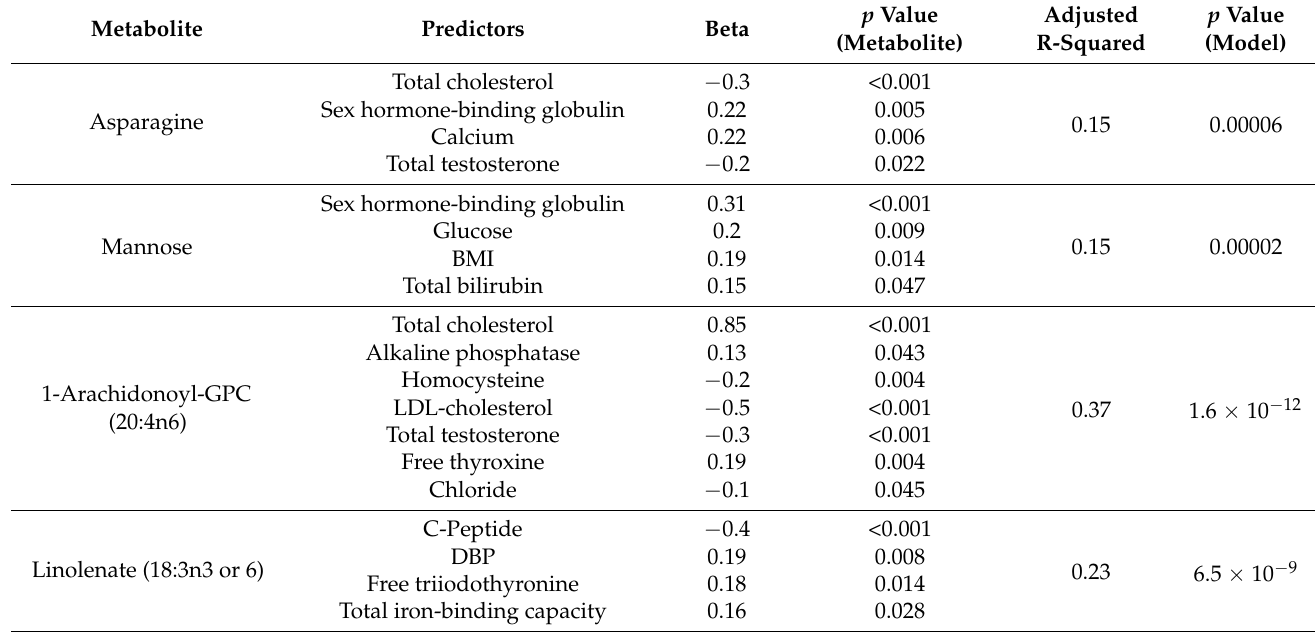
Table 4. Classical risk factors that best predict levels of CHD metabolites differentiating lean and overweight. A partial correlation analysis by stepwise linear regression was performed. Each model was run using 46 classical risk factors indicated in Table 1 per CHD metabolite. A p -value significance level of 0.001 was used for each model